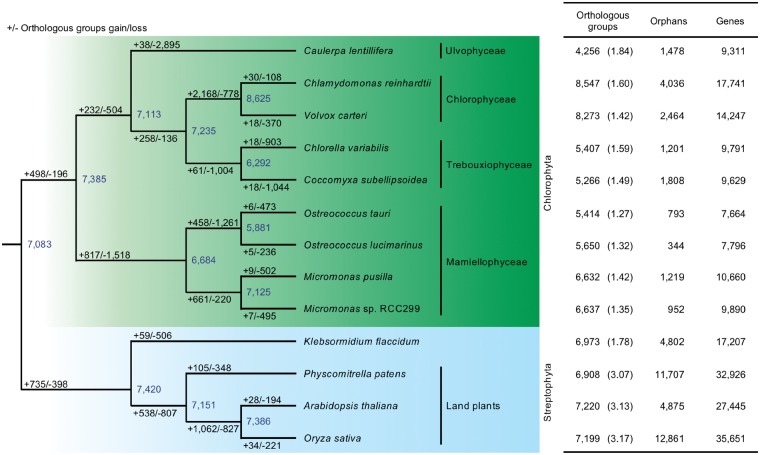
Evolution of gene families in green algae showing predicted gains and losses of orthologous gene clusters in each branch. This phylogenetic tree was constructed with the optimal maximum-likelihood method using a concatenation of 107 nuclear-gene-encoded protein alignments. Detailed information regarding the tree is shown in Supplementary Fig. S4. Numbers of assigned OGs, orphans, and genes are shown next to species names. Numbers in parentheses are average gene numbers in OGs.